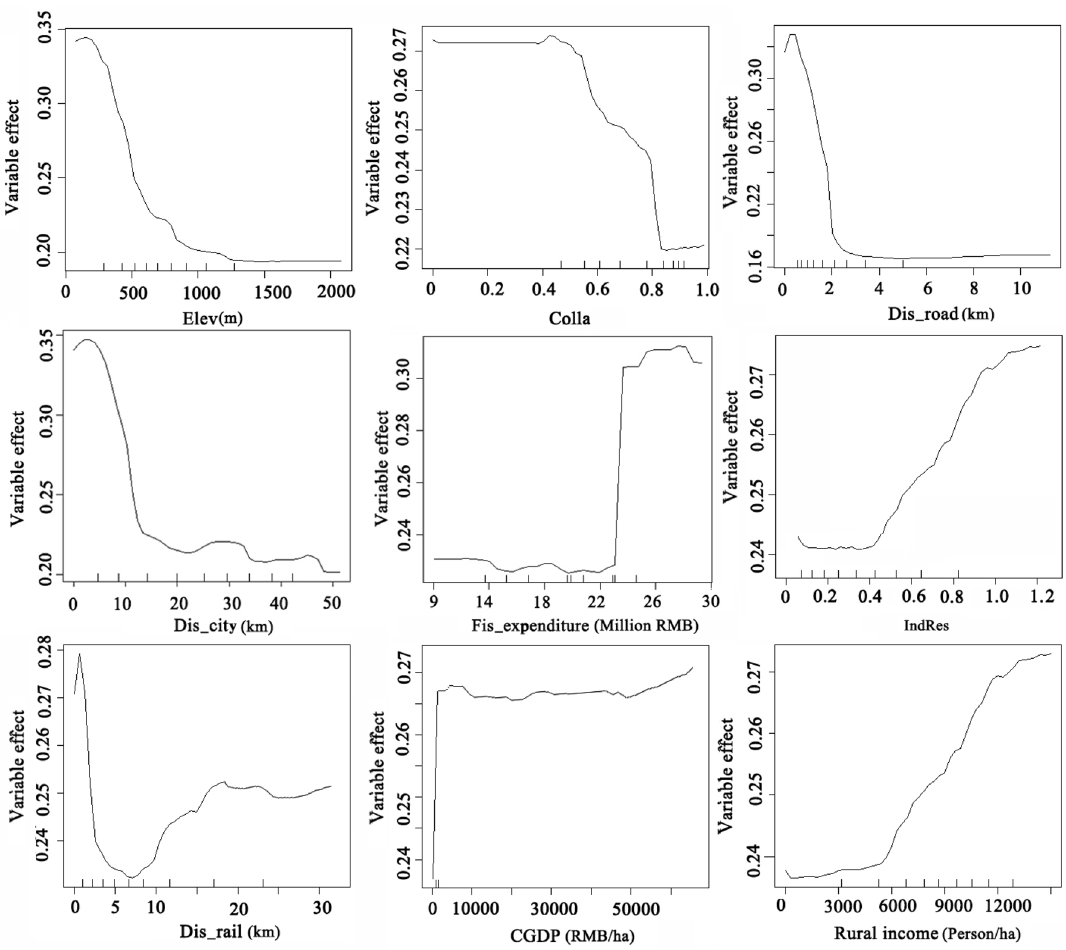
Figure 7. Partial dependence plots of the main influence factors on urban land expansion using